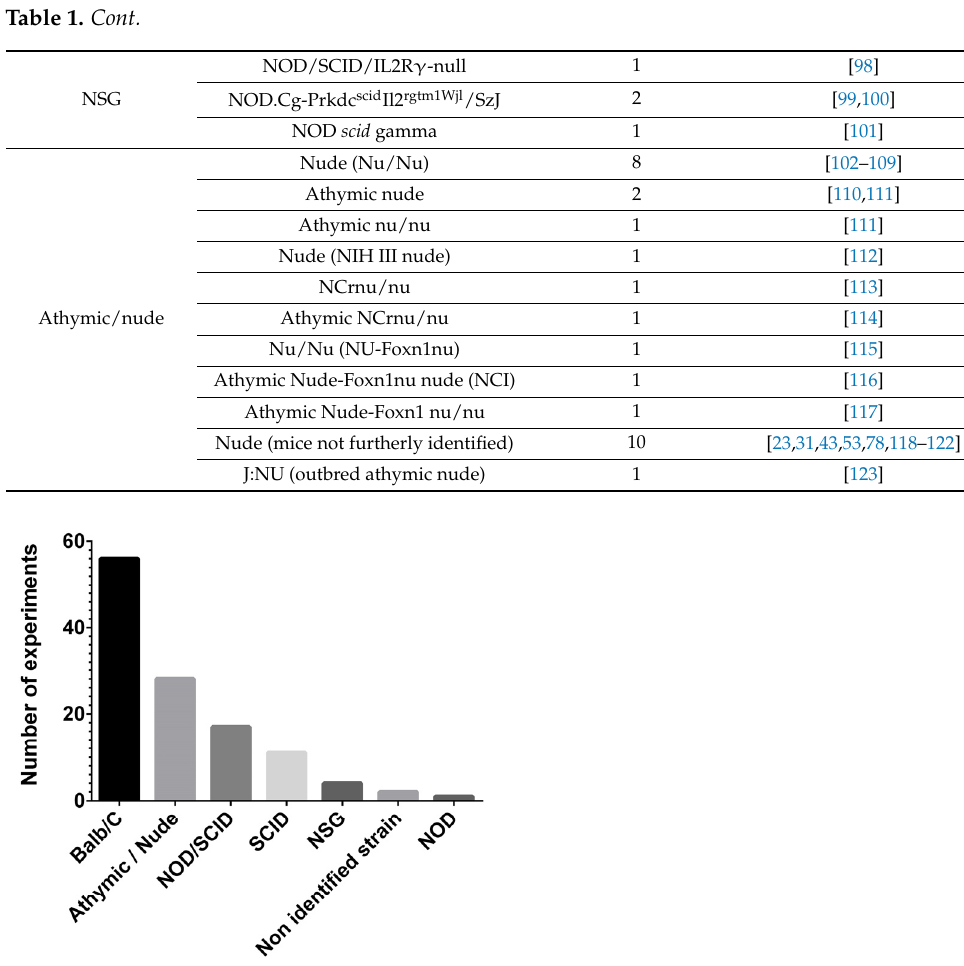
Figure 2. Number of experiments regarding the murine strain used in the articles analyzed. NOD: non-obese diabetic; SCID: severe combined immunodeficient mice; and NSG: NOD SCID gamma mouse.